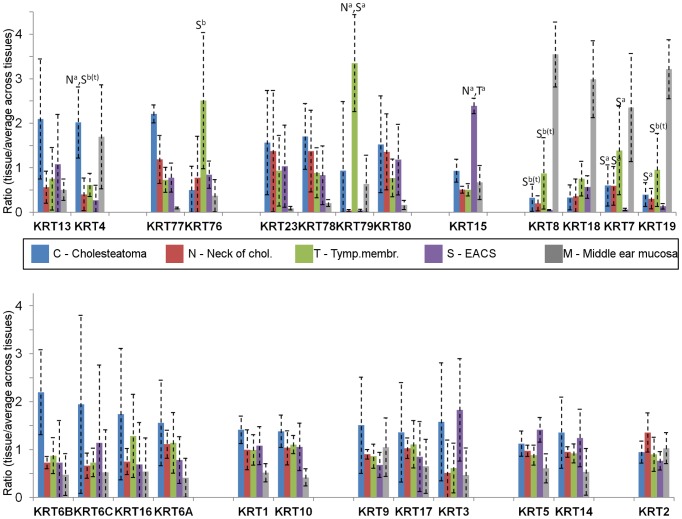
Cytokeratins.All identified cytokeratins (Hair- and hair follicle keratins excluded) were grouped according to Moll et al.[38]. Letters above the standard deviation bars indicate the tissues compared to which differences were found in the pairwise comparisons between the four keratinizing tissues (results from comparisons including the middle ear mucosa are not shown). a: Group A proteins; b: Group B proteins; b(t): Triplicate values in group B. Gene names shown below the columns. Tymp Membr: Tympanic membrane; Chol: Cholesteatoma.